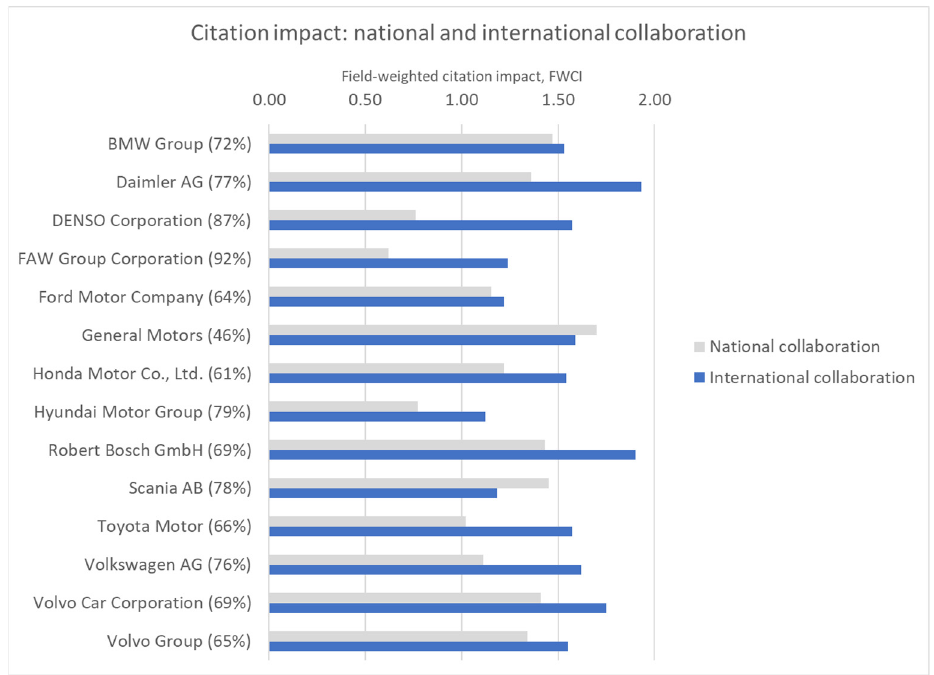
Figure 8. National and international co-publications in 2017–2021.